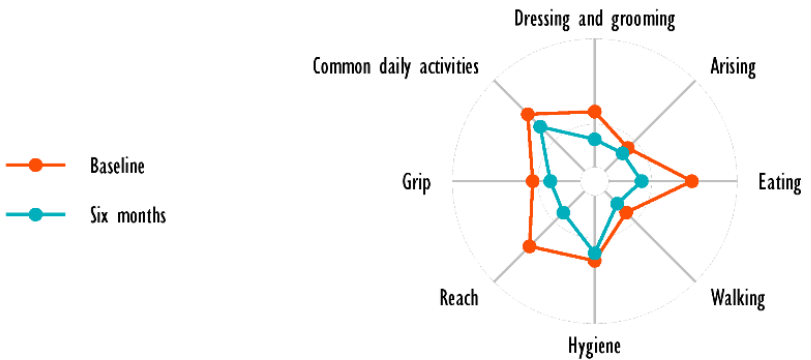
Figure 5. Trend of the HAQ at baseline and after 6 months of therapy.